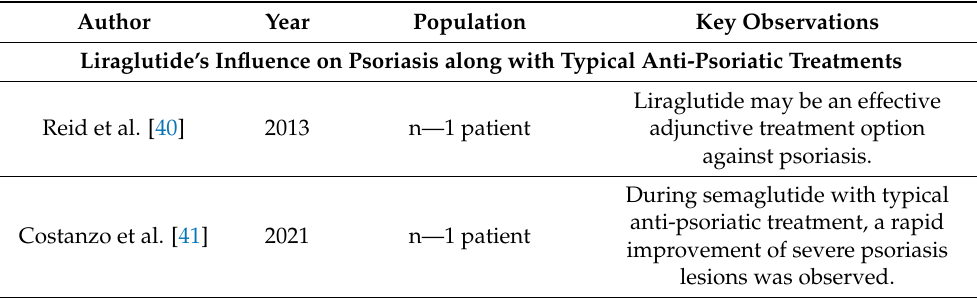
Table 18. Summary of the studies on liraglutide’s influence on psoriasis along with typical anti- psoriatic treatments. Year